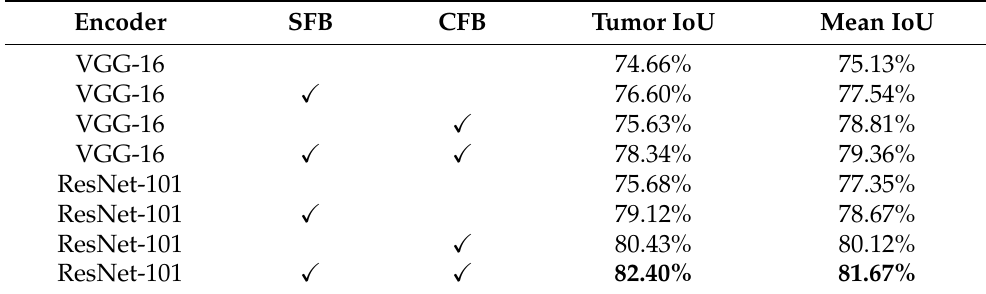
Table 2. Ablation Study on Multi-object Dataset. SFB: Spatial-wise Fuzzy Block, CFB: Channel-wise Fuzzy